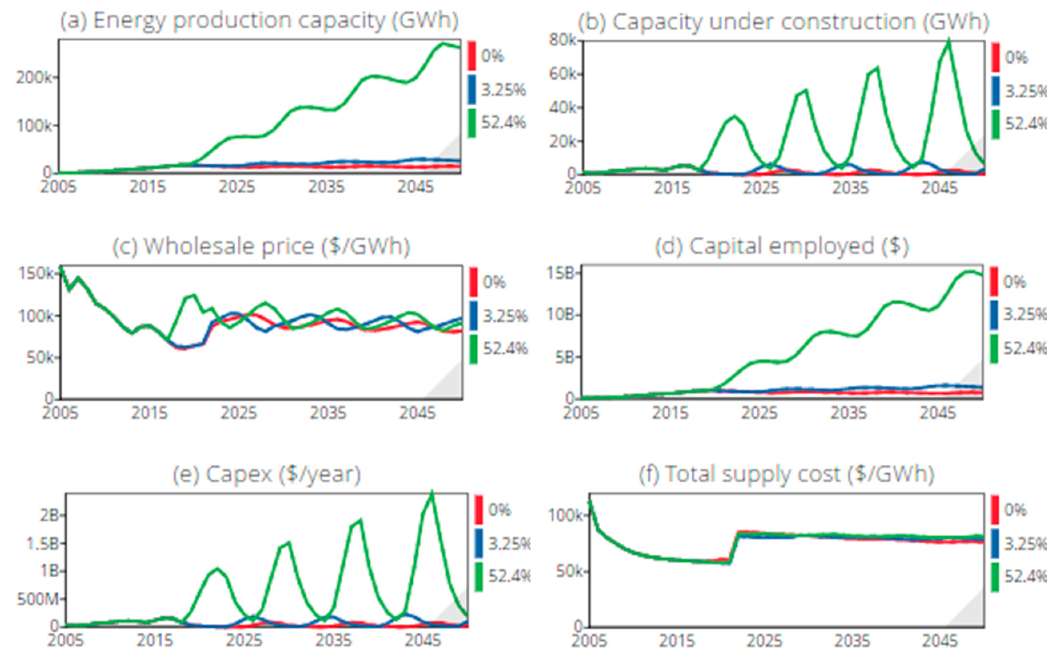
Figure 8. Extreme condition test results for wind for ( a ) production capacity, ( b ) capacity under construction, ( c ) wholesale price, ( d ) capital employed, ( e ) capex and ( f ) total supply. The coloured lines on each graph represents (1) gross demand growth rate set to 0% (no growth), (2) base case scenario with gross demand growth rate set to 3.25% (current trend) per year for 2017, (3) gross demand growth rate set to 52.4% (maximum).